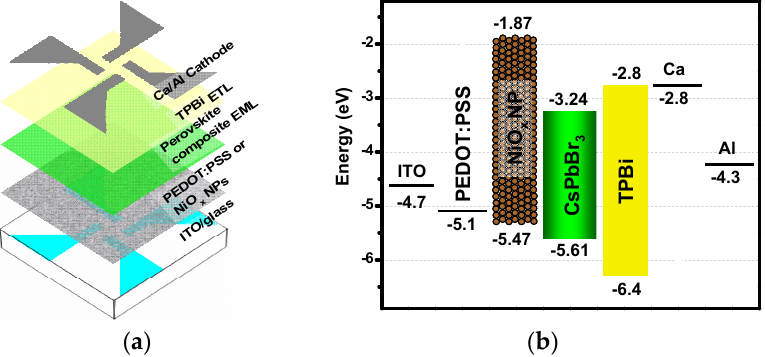
Figure 1. ( a ) Schematic PeLED architecture and ( b ) corresponding energy band diagram with an alternative hole transport layer (HTL), poly (3,4-ethylenedioxythiophene): poly (styrenesulfonate) (PEDOT:PSS), or NiO x nanoparticles (NPs).